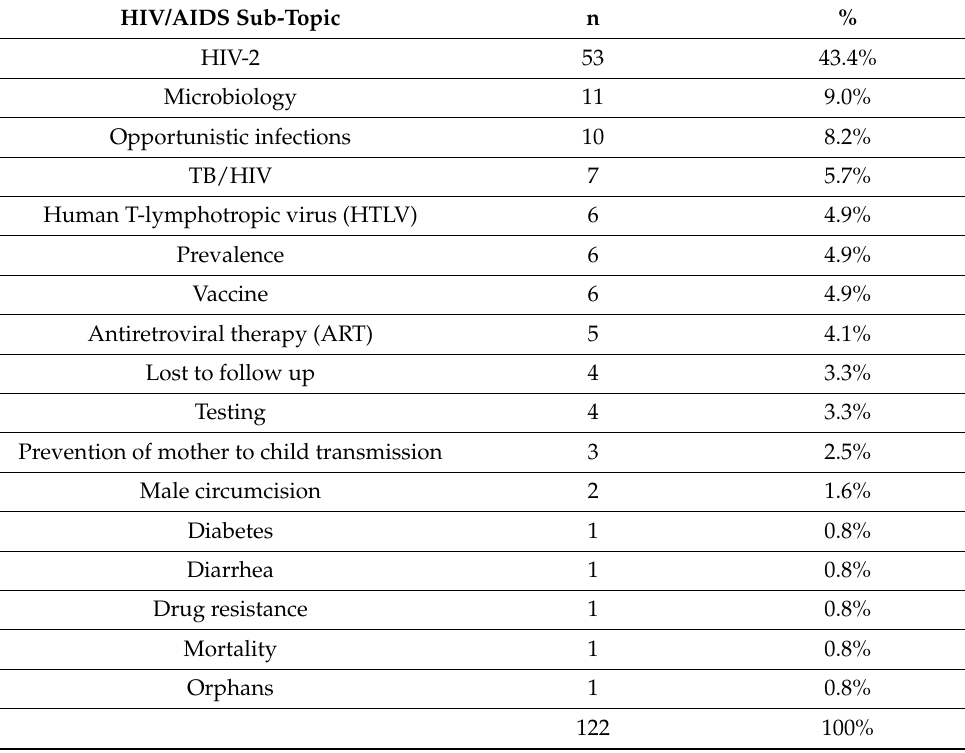
Table 2. HIV/AIDS sub-topics (n = 122).